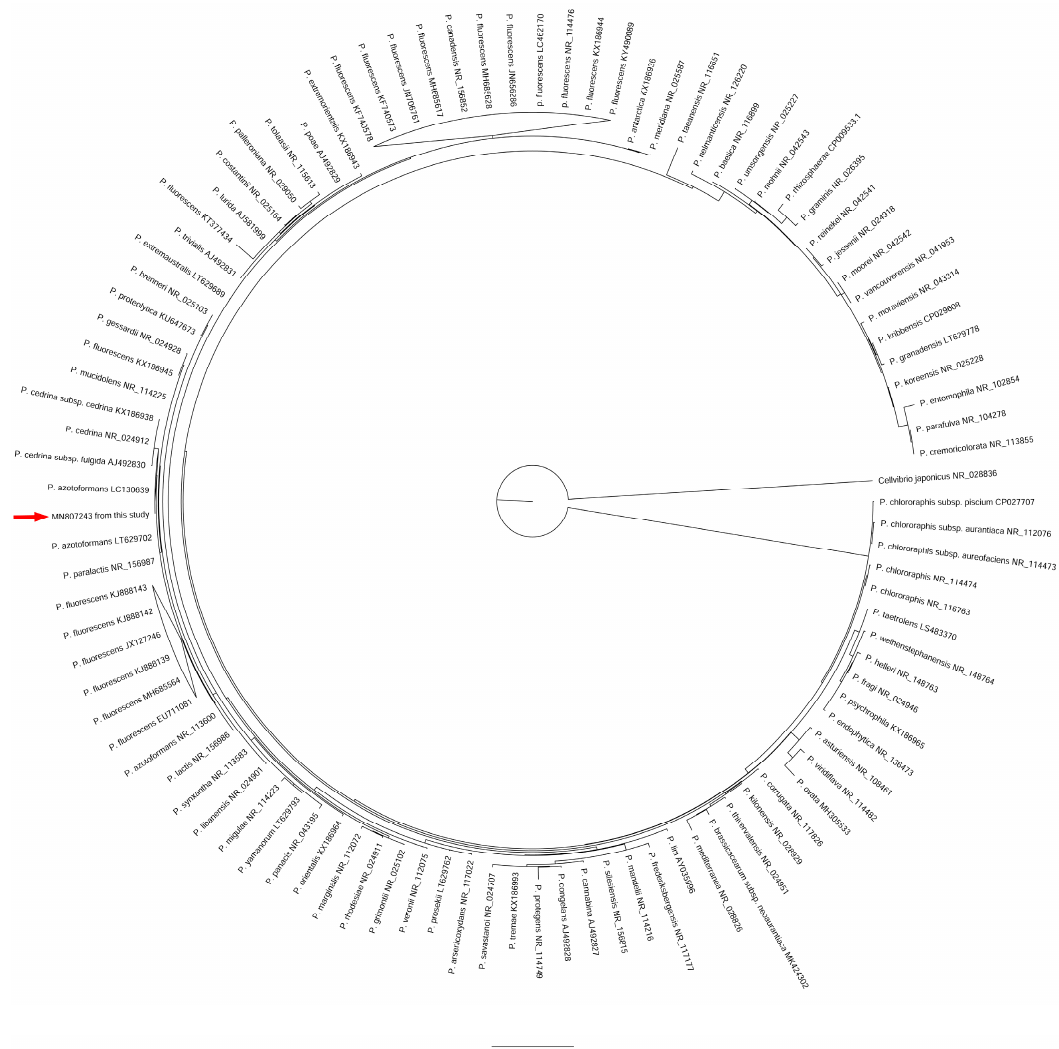
Figure 2. Maximum likelihood phylogenetic tree based on the nucleotide sequence of the 16S rRNA genes among members of the Pseudomonas genus. Red arrow indicates the sequence from this study.